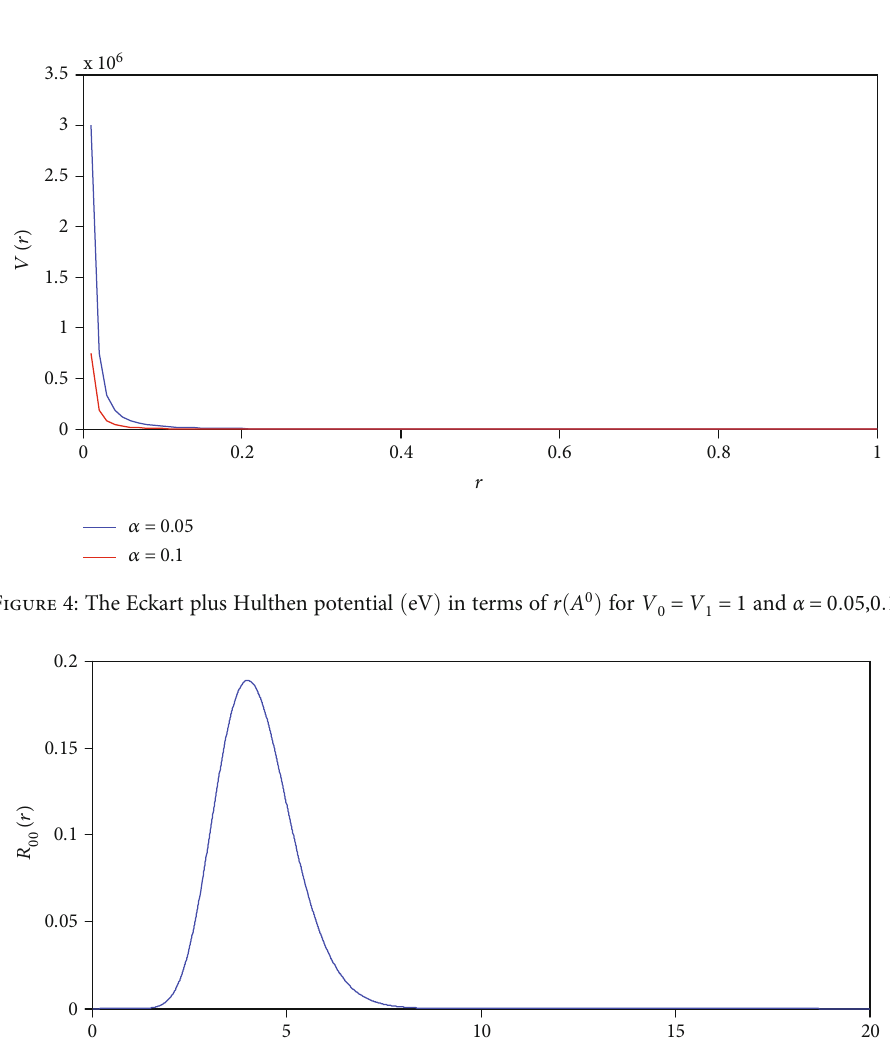
= V = 1 in atomic units 0 1